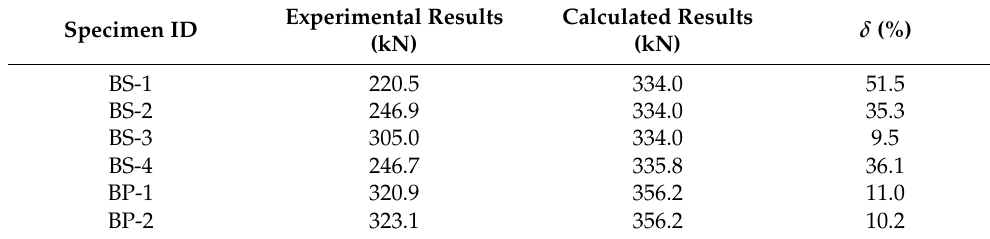
Table 6. Comparisons of predicted and tested ultimate